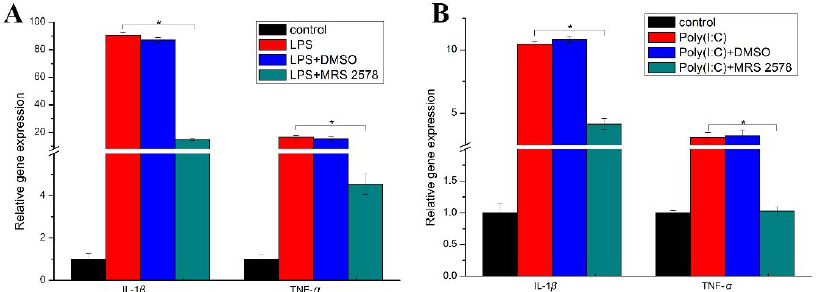
Figure 6. Effects of P2Y 6 receptor antagonist MRS 2578 on pathogen ‐ associated molecular pattern (PAMP) ‐ induced pro ‐ inflammatory cytokine gene expression in Japanese flounder PBL cells. Japanese flounder PBL cells were pre ‐ incubated with 10 μ M MRS 2578 for 30 min and then stimulated with 20 μ g/mL LPS ( A ) or poly(I:C) ( B ) for 2 h in the presence of 10 μ M MRS 2578 or same volume of vehicle DMSO. The relative gene expression level of IL ‐ 1 β and TNF ‐α was determined by quantitative real ‐ time RT ‐ PCR and normalized to untreated control cells (set to 1). Data are presented as means ± standard deviations of triplicate determinants from one representative experiment. Similar results were obtained in two other separated experiments. Significance between PAMP and PAMP plus MRS 2578 treated groups is determined by the Student’s t ‐ test and is indicated by brackets and asterisks at p < 0.05.